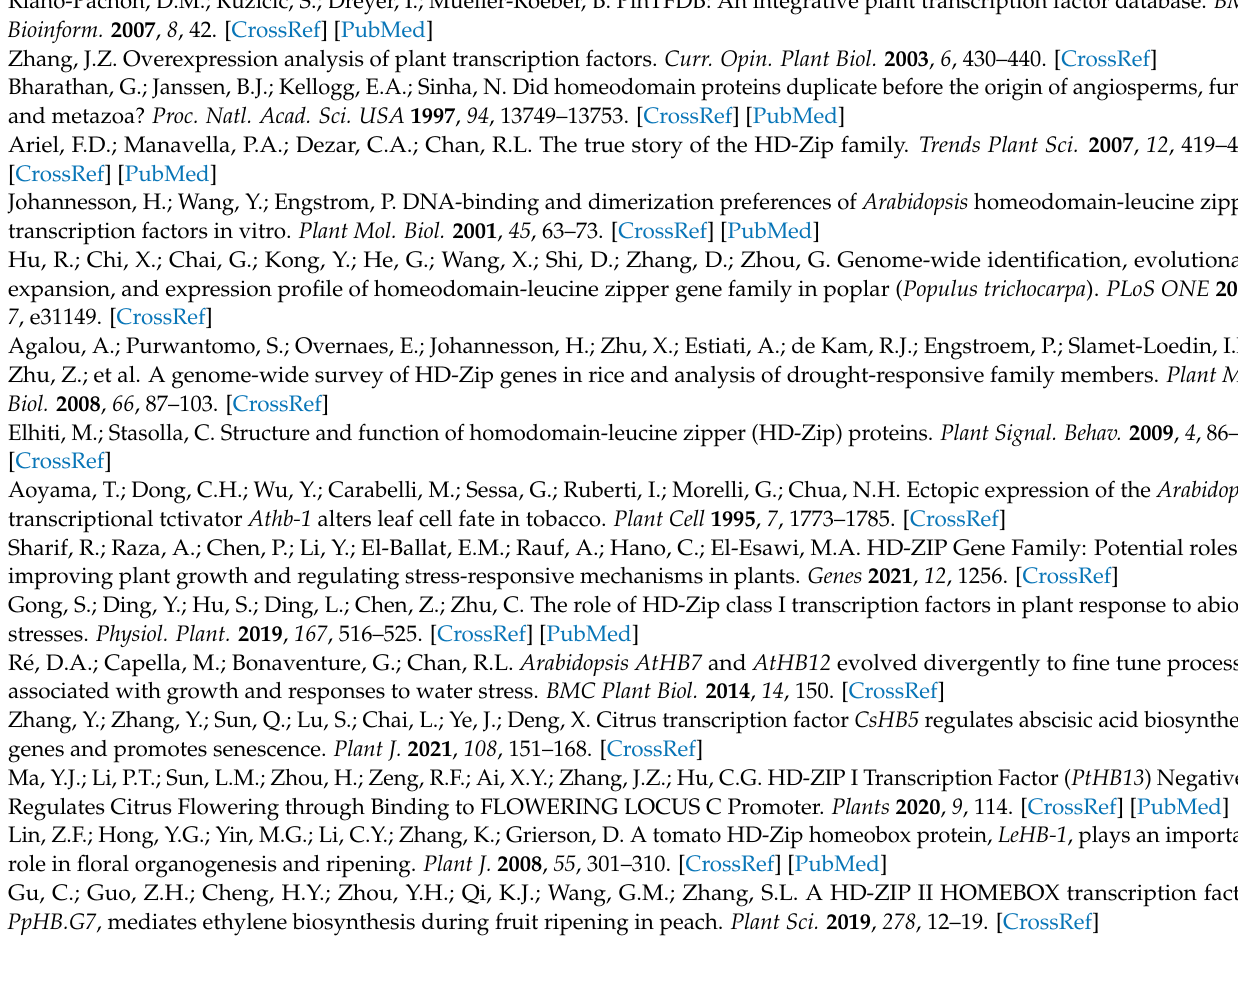
Table S4: The primers used in the yeast one-hybrid assays; Table S5: The primers used in our study for